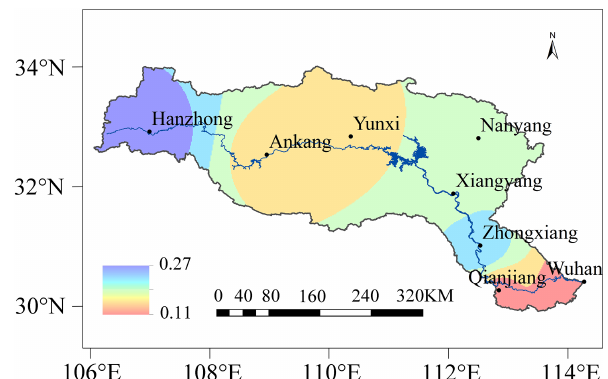
Figure 9. Spatial distribution of Pearson’s correlation coefficients of drought and flood grades between eight sites of the HRB and North China on average (1470–2000). The correlation coefficients for Hanzhong, Ankang, Yuxi, Nanyang, Xiangyang, Zhongxiang, and Qianjiang are significant at the 0.01 level, and that for Wuhan is significant at the 0.05